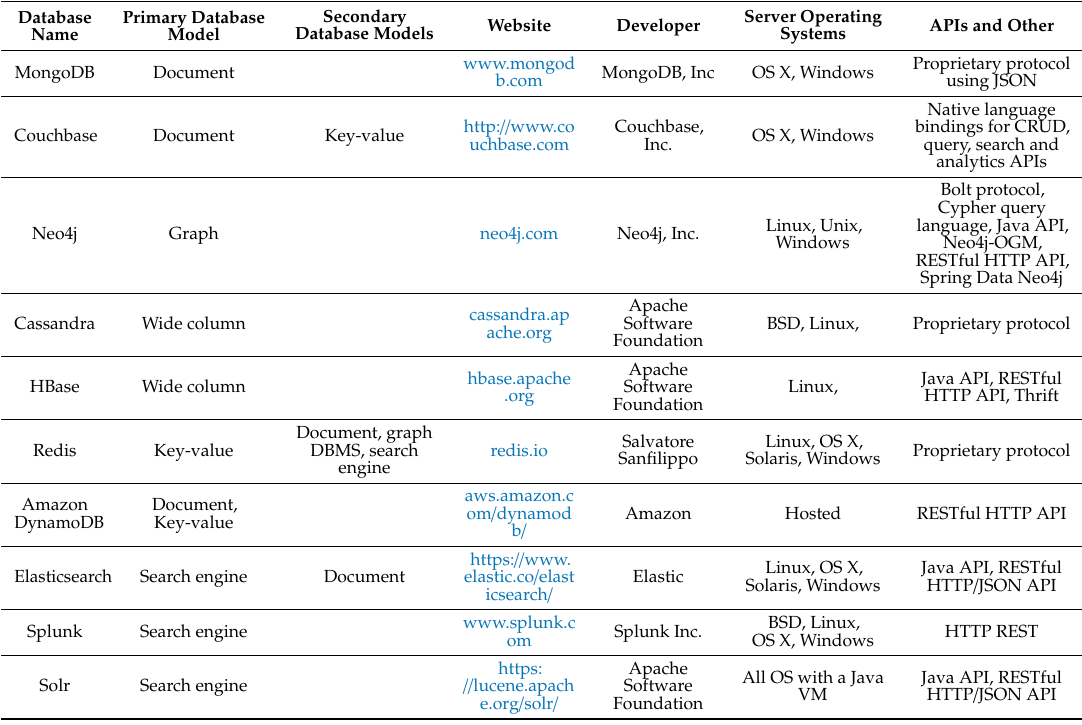
Table 3. Basic information about the 10 NoSQL databases. DBMS, relational database management